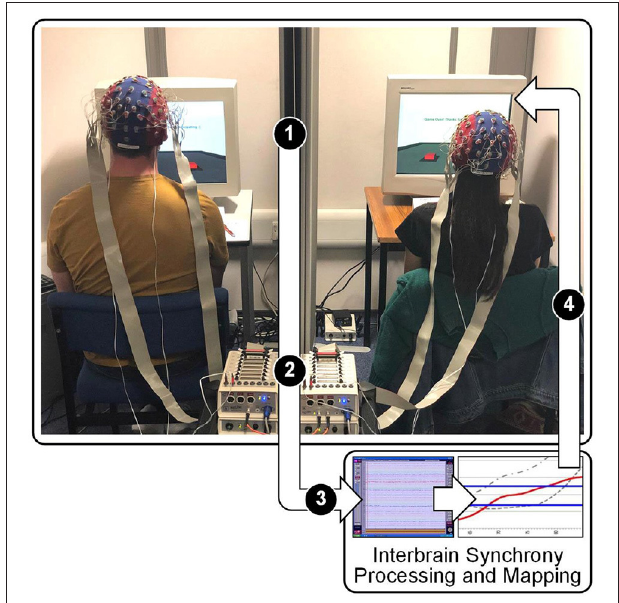
FIGURE 2 | The InBS-NF paradigm: 1) an interactive simulation incorporates the level of interbrain synchronicity shown visually to the participants, 2) raw EEG is measured from both participants is transmitted to the amplifier, 3) InBS is computed from the raw EEG, 4) any changes in synchronicity effects the simulation towards the direction of